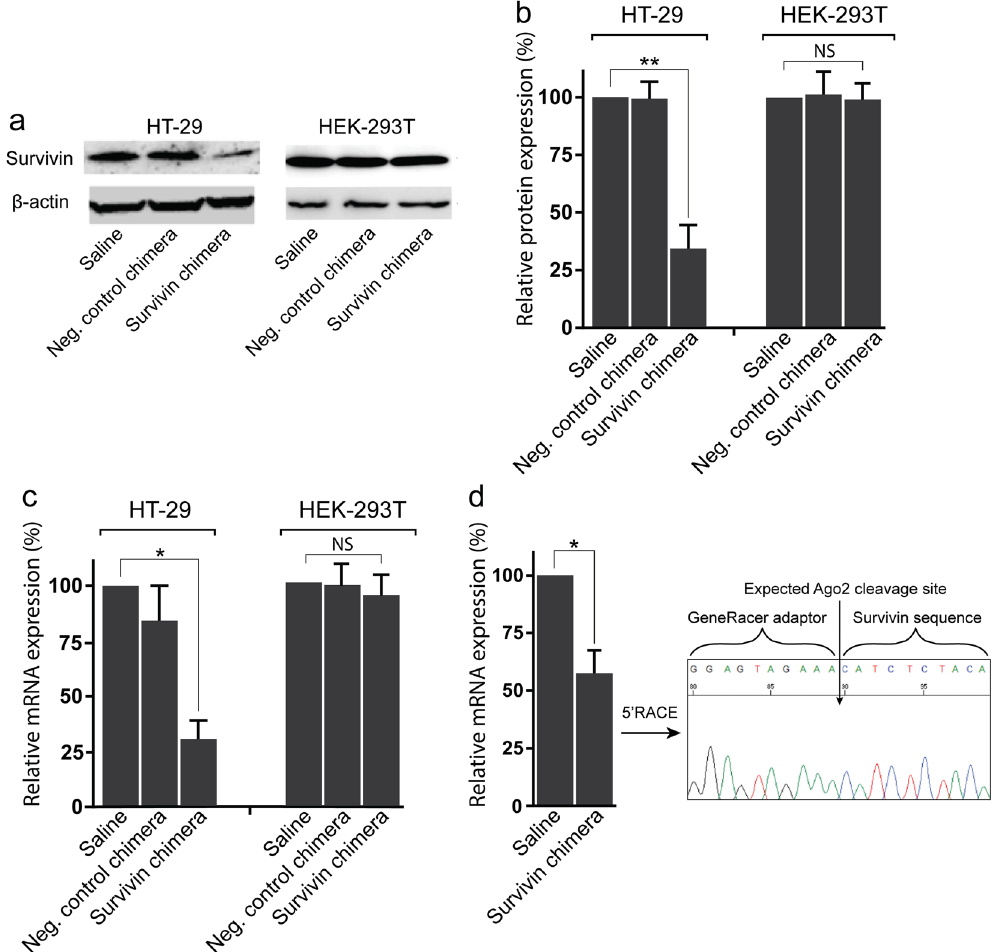
Figure 1. EpCAM aptamer-guided RNAi effectively silenced survivin. ( a ) Specificity and efficacy of EpCAM- aptamer guided RNAi in knocking down survivin mRNA. Chimera or negative control chimera were incubated with HT-29 or HEK-2913T cells for 24 hours and the total RNA was extracted for qRT-PCR analysis of survivin mRNA levels. GAPDH was used as an internal control. ( b , c ) HT-29 Tumour-bearing mice were treated with 2 nmol/mouse of PEG-labelled chimera for 48 hours. The tumours were collected for RNA extraction followed by qRT-PCR analysis of survivin mRNA expression ( b ) and 5 ′ RACE assay ( c ). ( d ) Effective downregulation of survivin protein via EpCAM aptamer-guided RNAi. Chimera or negative control chimera were incubated with HT-29 or HEK-2913T cells for 48 hours and the survivin protein levels were analyzed using Western blot analysis. β -actin was used as a loading control. ( e ) The bar graph shows the survivin protein levels in various treatment groups. Data shown are means ± SEM, n = 3. * p < 0.05, ** p < 0.005. NS, no statistically significant